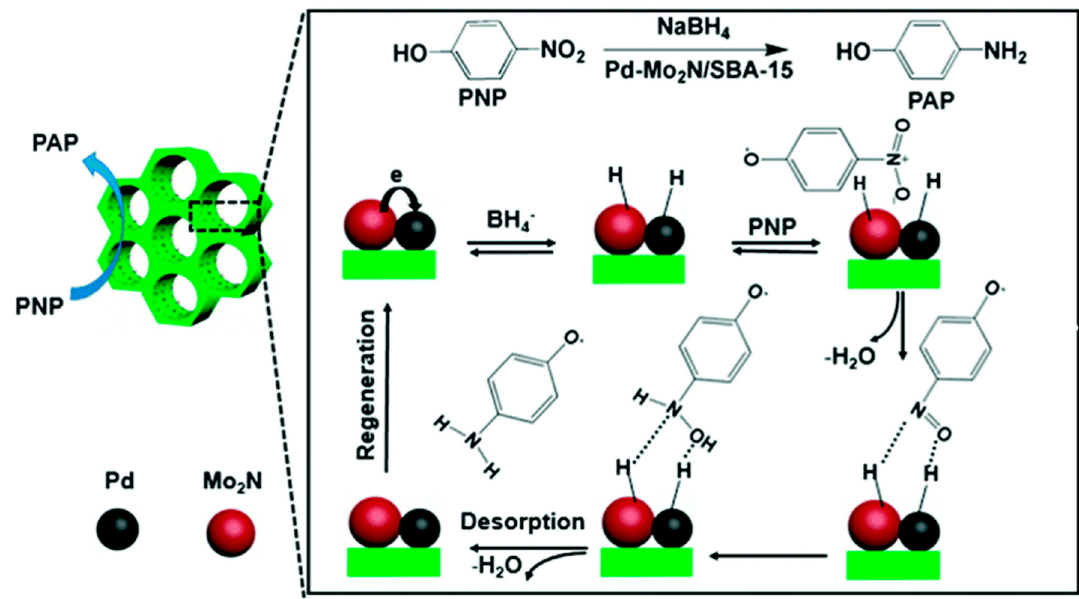
Figure 9. Catalytic conversion mechanism of PNP into PAP over the Pd–Mo 2 N / SBA-15 hybrids in the presence of NaBH 4 . Reproduced from [53], with permission from American Chemical Society, 2018.